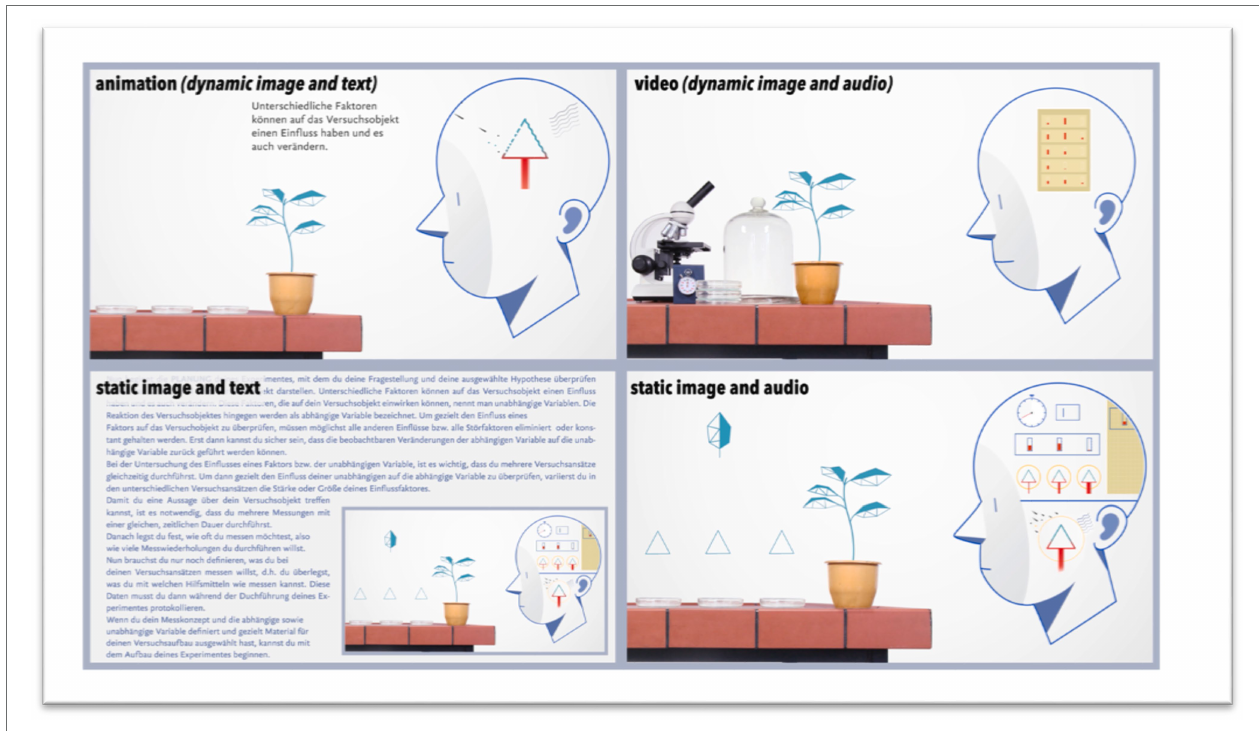
FIGURE 2 | Image sections of the scaffolds in the different multimedia representation